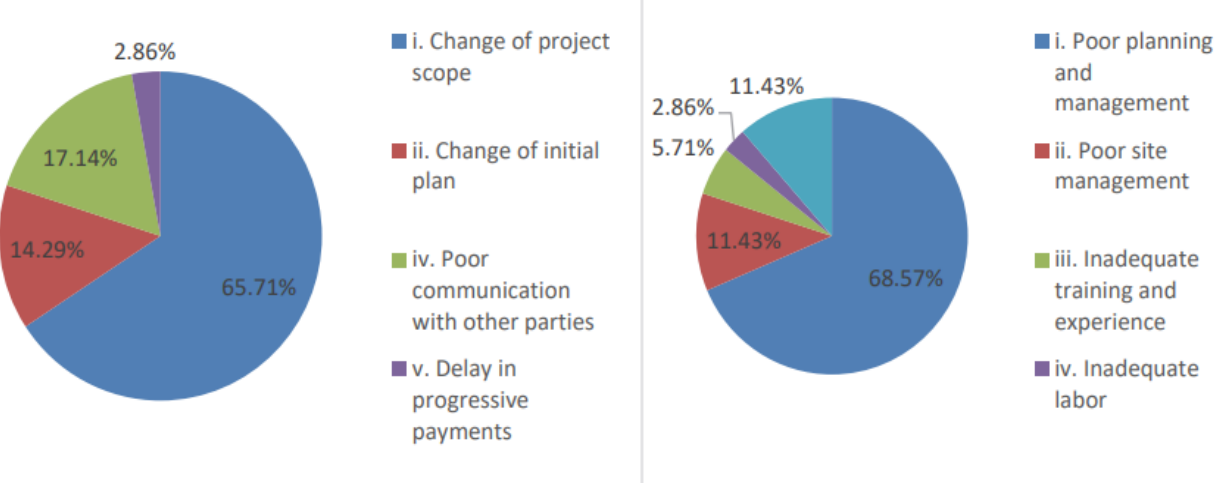
Figure 3. Client- and contractor-related causes for cost overruns [39].